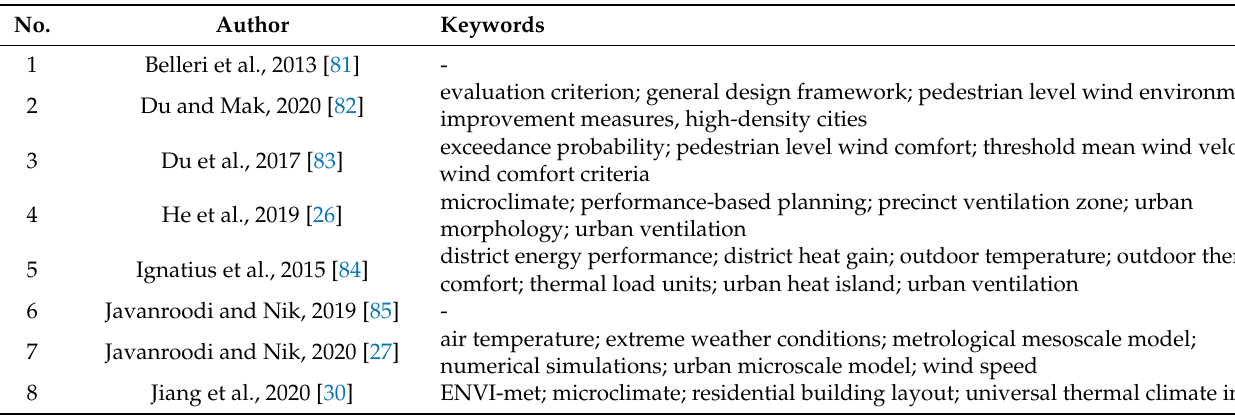
Table 10. Overview of studies of real urban areas with validation comparison with experimental or numerical data: listed